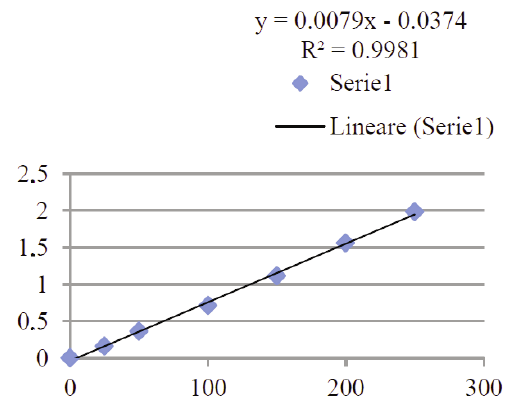
Fig. 3 ­ Standard graph of flavonoids measurement.